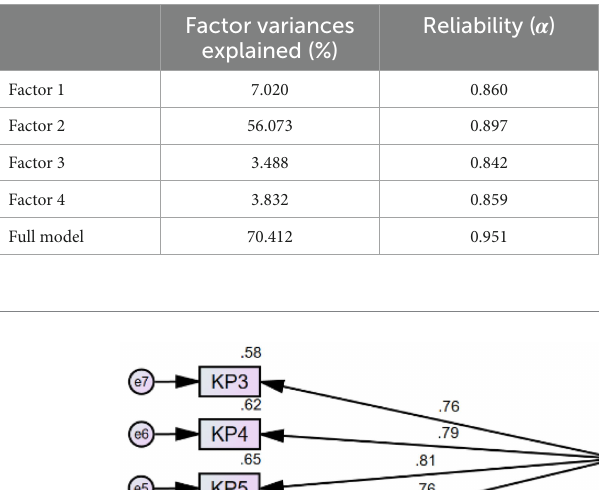
TABLE 7 Factor variances and reliability tests.